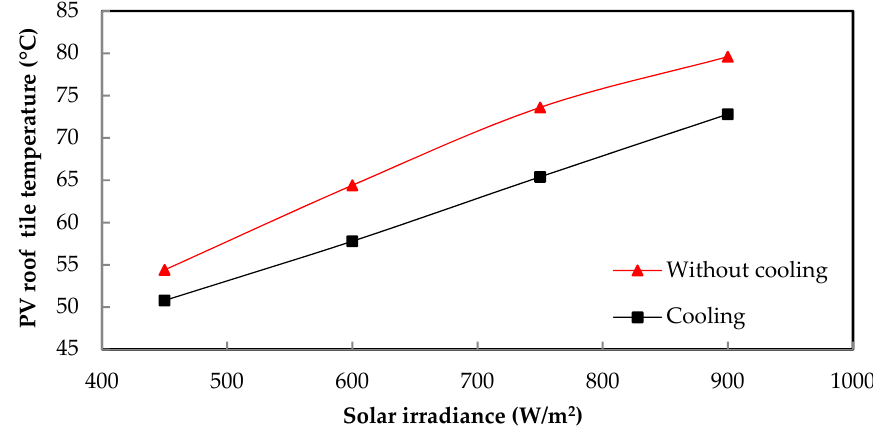
Figure 6. The PV roof tile temperature variation with the solar irradiance, with the cooling air flow rate at 𝑉(cid:4662) = 5 m 3 /h.